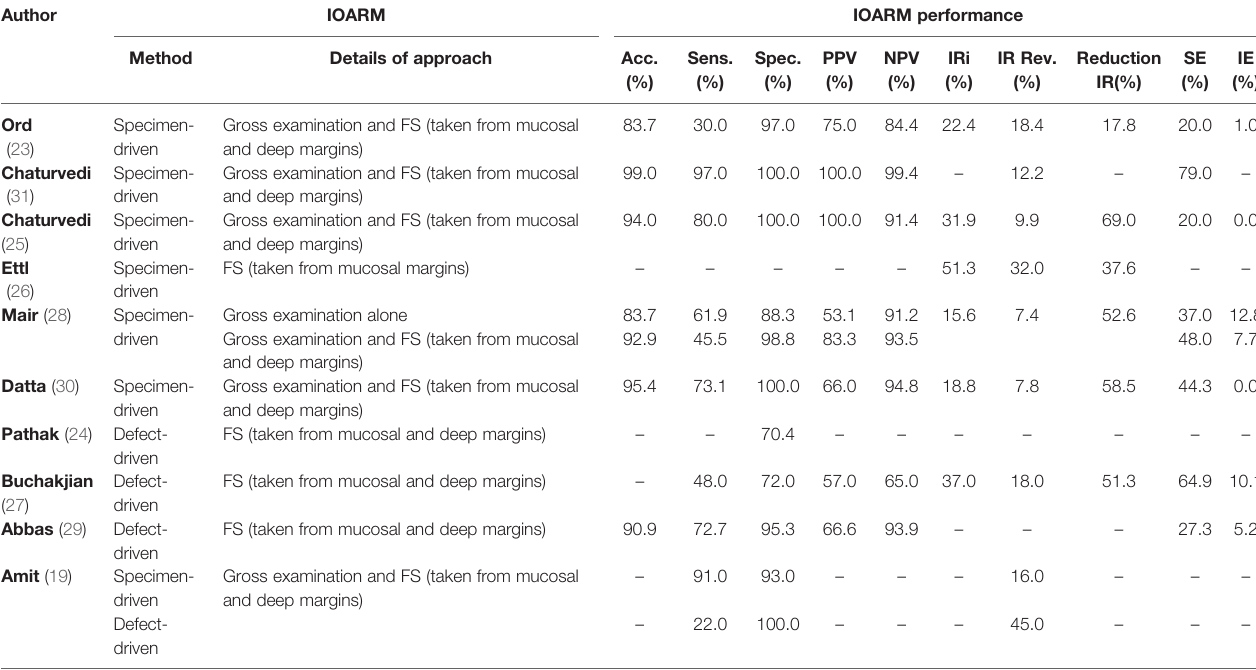
TABLE 2 | IOARM methods in soft tissue: description and performance.